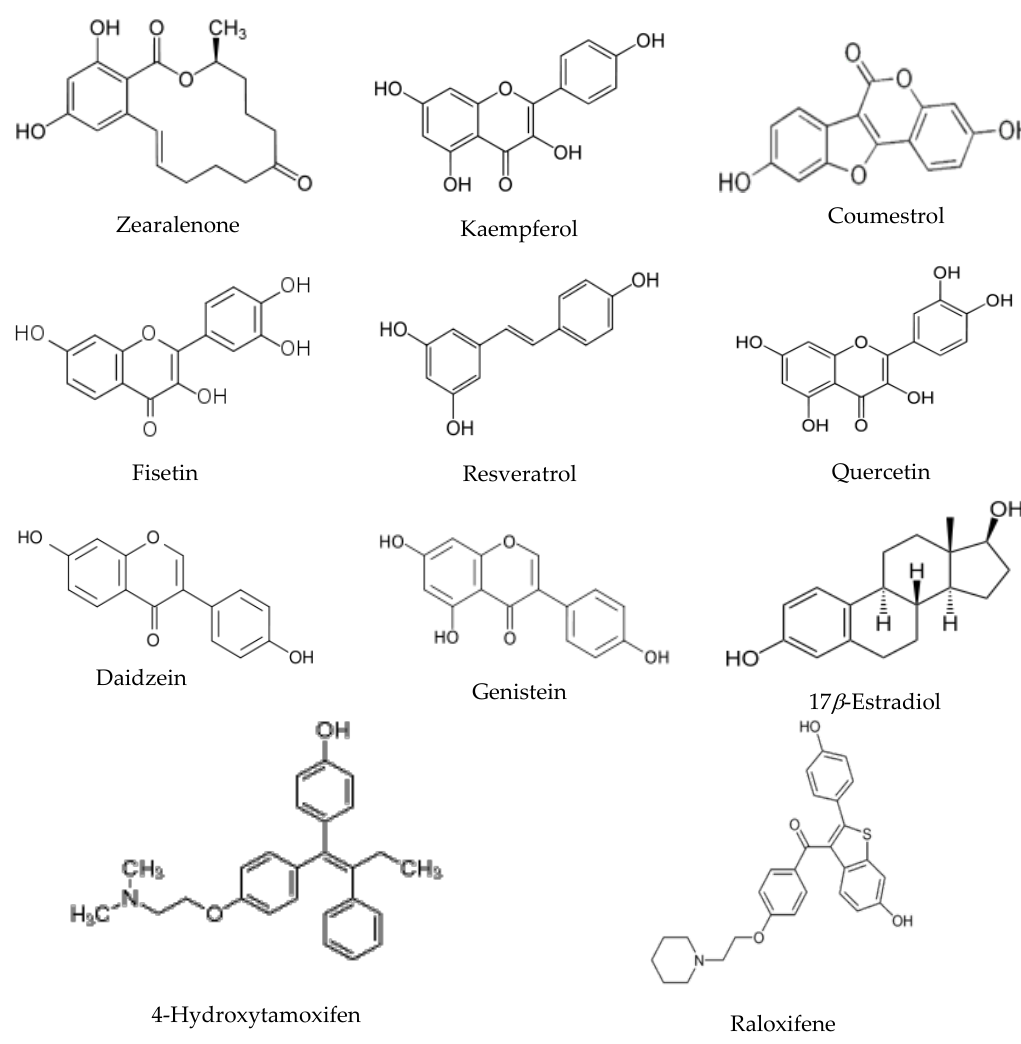
Figure 1. Chemical structure of ER ligands.